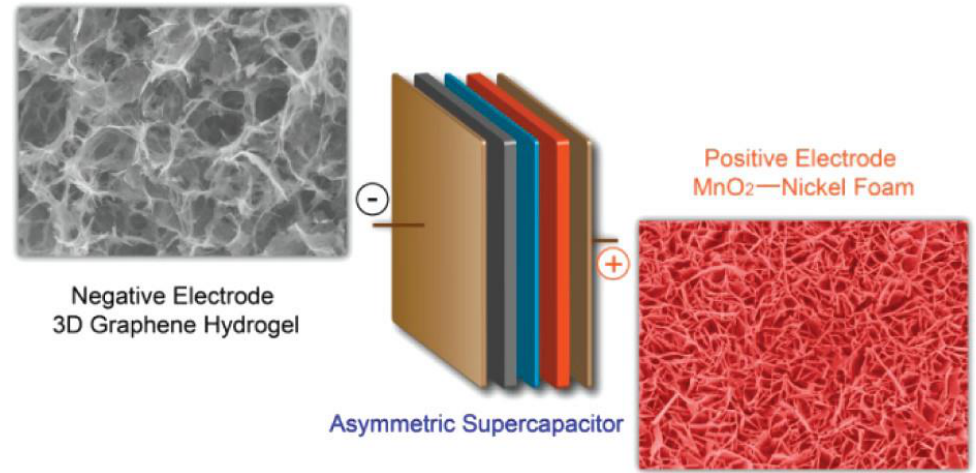
Figure 2. Graphical representation of an HSC device with graphene hydrogel and MnO 2 nanoflakes. Reprinted with permission from [58].